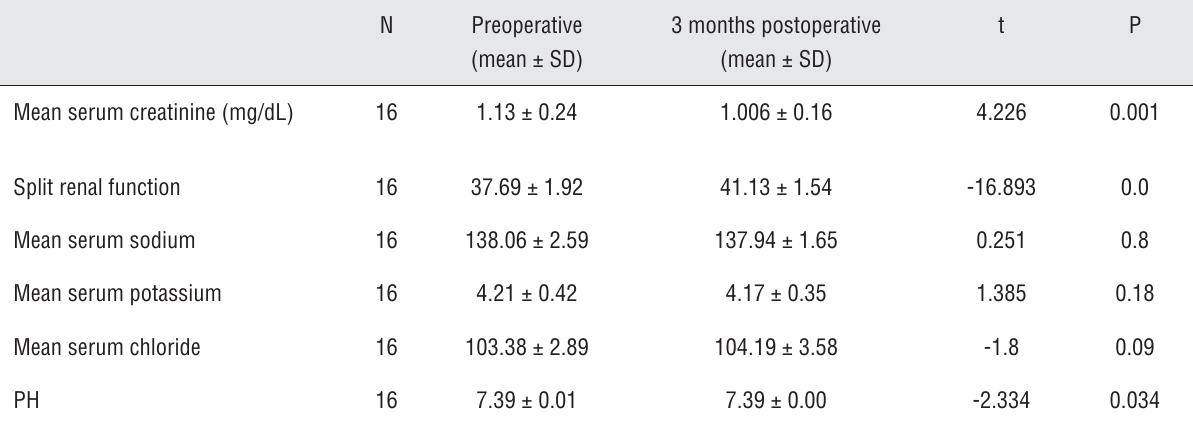
Table 1 - Preoperative and 3 months postoperative results of laboratory investigations and split renal function. N Preoperative (mean ±